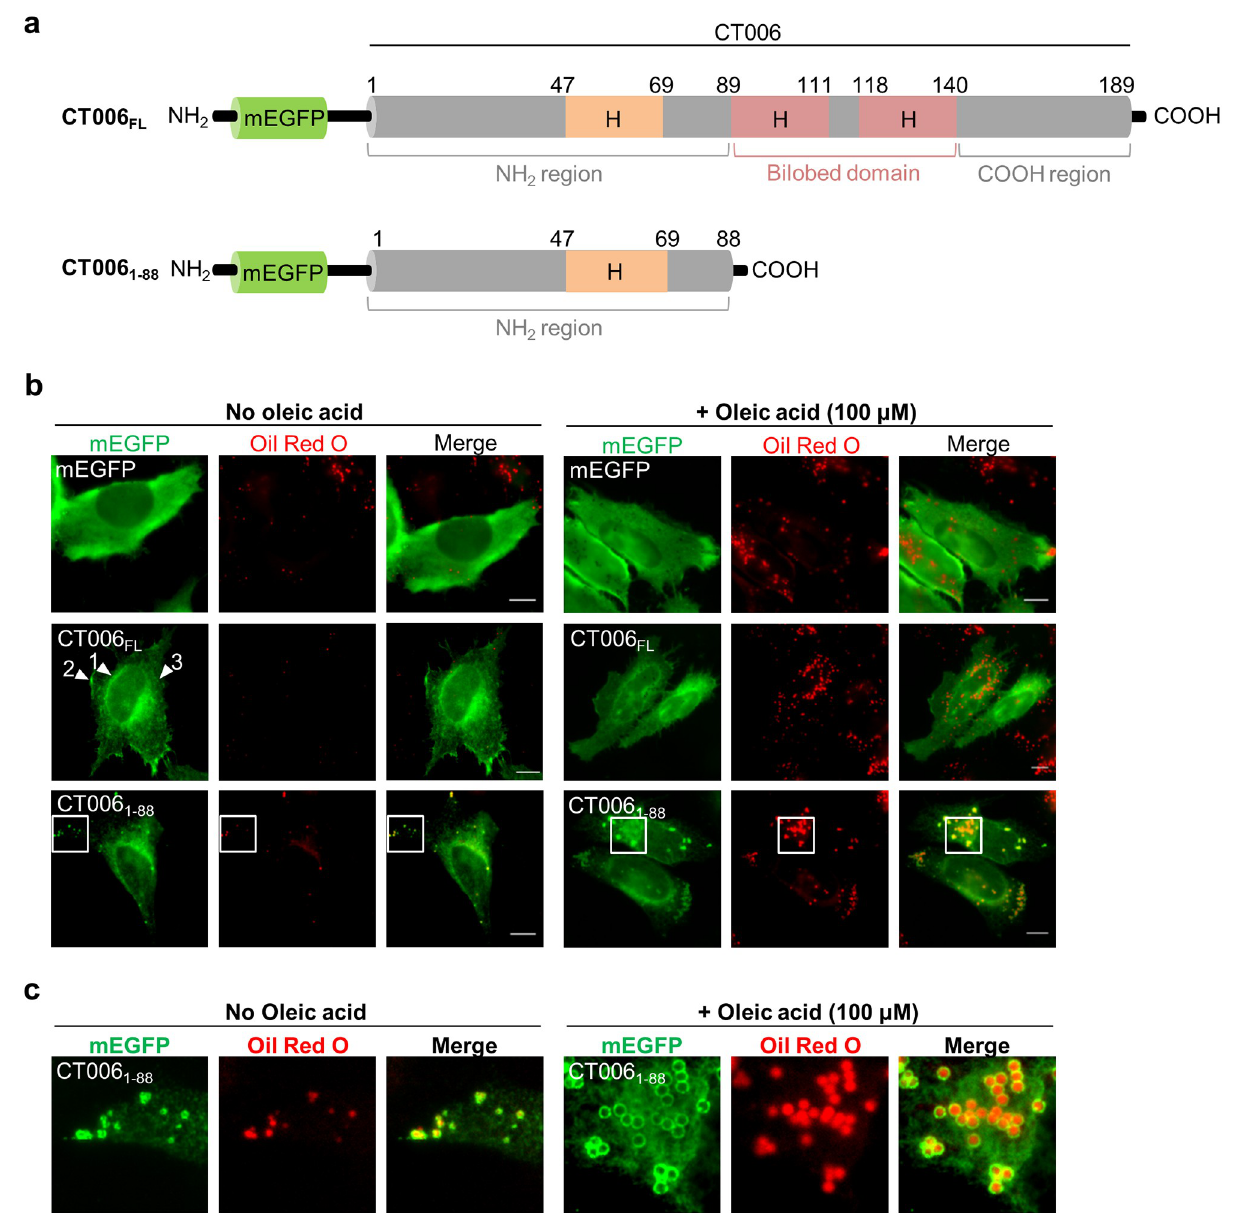
Fig 3. The first 88 amino acid residues of CT006 fused to mEGFP co-localize with LDs in mammalian cells. HeLa 229 cells were transfected with plasmids encoding mEGFP or different regions of CT006 containing a mEGFP tag at their amino-termini (mEGFP-CT006 proteins). (a) Schematic representation of mEGFP-CT006 and mEGFP-CT006 1-88 (not drawn to scale); H, Putative hydrophobic domain. (b) At 18 h post-transfection, cells were either treated with ethanol (solvent control; left-hand side panel) or 100 μ M oleic acid (right-hand side panel) for 6 h and then fixed with 4% (w/v) PFA. Fixed cells were labeled with anti-GFP and the appropriate fluorophore-conjugated secondary antibody, stained with Oil Red O (3:2 v/v Oil Red O stock solution diluted in water), and imaged by fluorescence microscopy. Scale bars, 10 μ m. Arrowheads indicate the reticular distribution of mEGFP-CT006 FL (1) and the accumulation in patches near the plasma membrane (2) or cytosol (3). (c) In the area delimited by white squares (Fig 3b) images were zoomed.